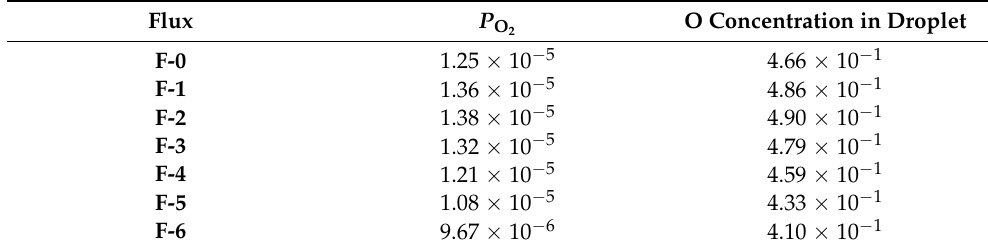
(atm) and O concentration (wt pct) in the droplet. 2